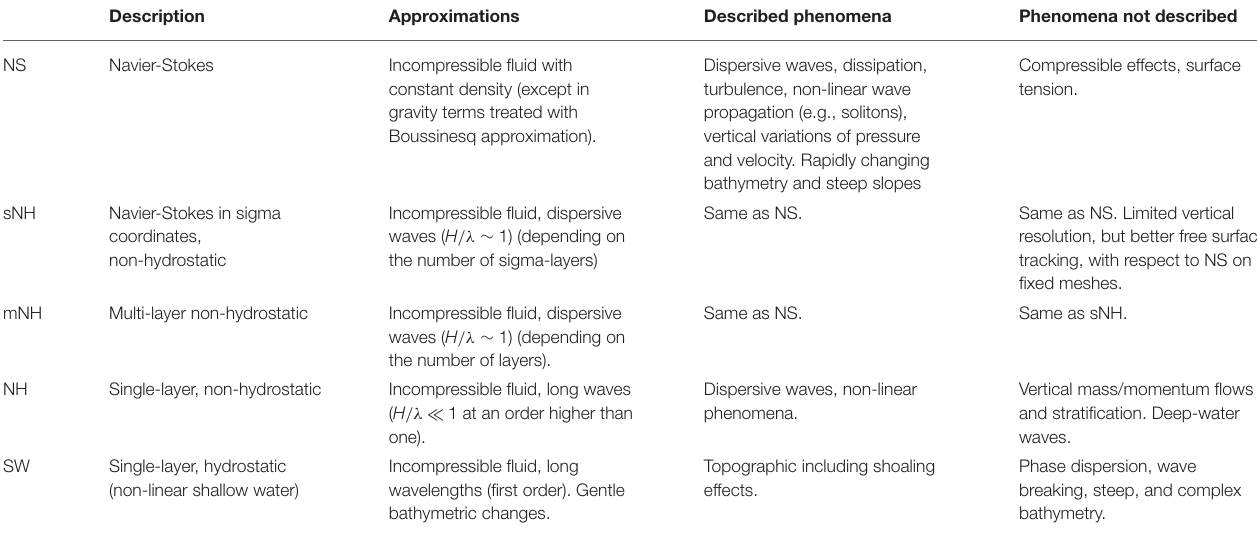
TABLE 2 | Acronym and hierarchy of the different approaches to the modeling of water waves, ordered from top to bottom by decreasing